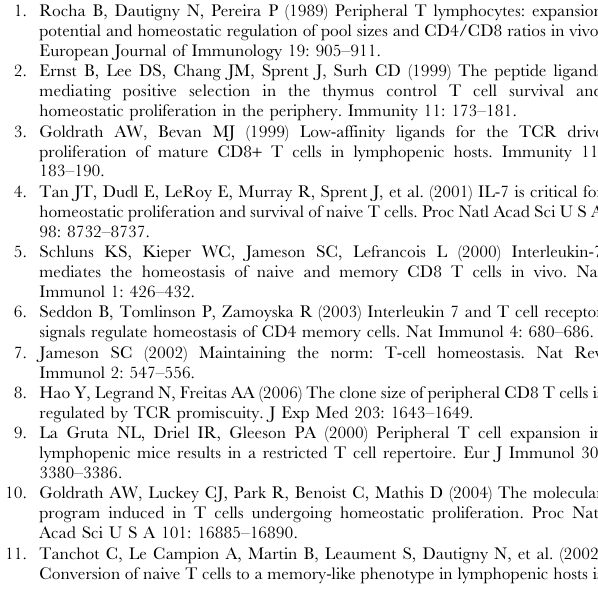
Figure S5 Role of CD11c + APCs. ( A ) CD40 expression among the host CD11c + cells (left) and the total number of host CD11c + cells (right) recovered 17 days after 2 6 10 4 CD8 + T cells were transferred alone or with 2 6 10 4 CD4 + T cells into CD3 e 2 / 2 mice. (** p # 0.01). Values outside the histogram represent the mean 6 se (right). To enumerate CD11c + cells, spleen and LNs were incubated 45 min at 37 u C in RPMI containing DNAse I (50 m g/ml) and collagenase type IV (1 mg/ml). In the presence of CD4 + T cells, the number of CD11c + cells and their CD40